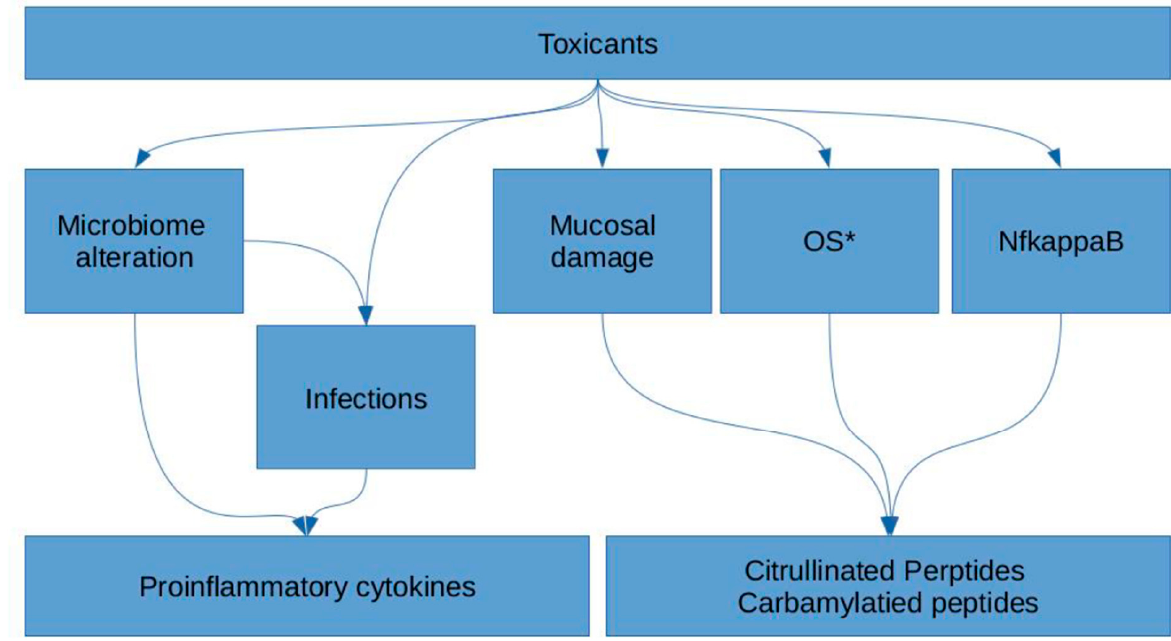
Figure 3. Possible mechanisms of implementation of triggering role of ecotoxicants in RA. OS*—oxidative stress.